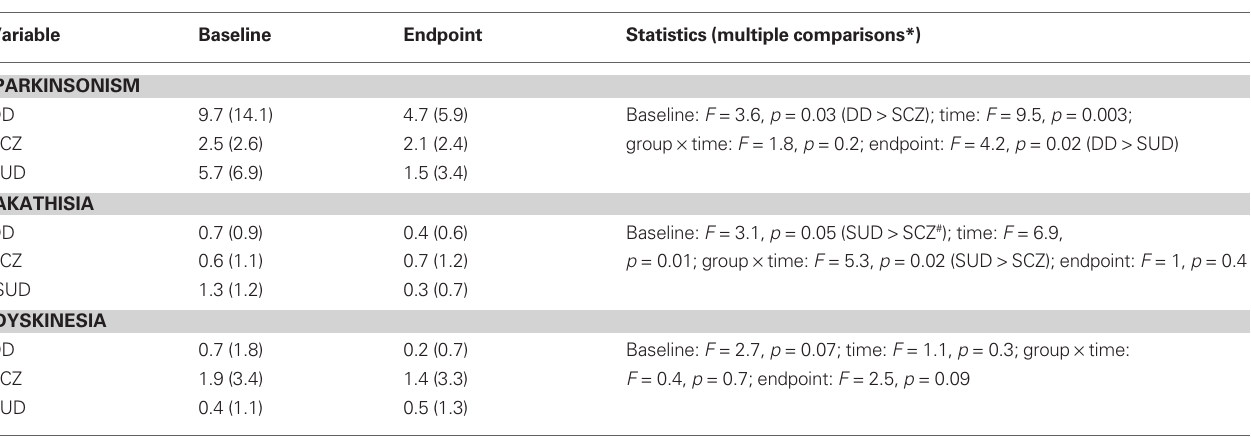
Table 3 | neurological symptoms at baseline and endpoint.